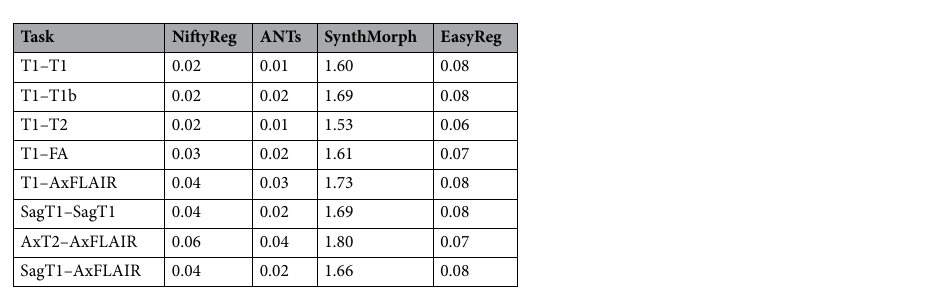
Table 2. Average inverse consistency errors (in mm), for the different methods and registration tasks. Errors are averaged over voxels inside the brain.